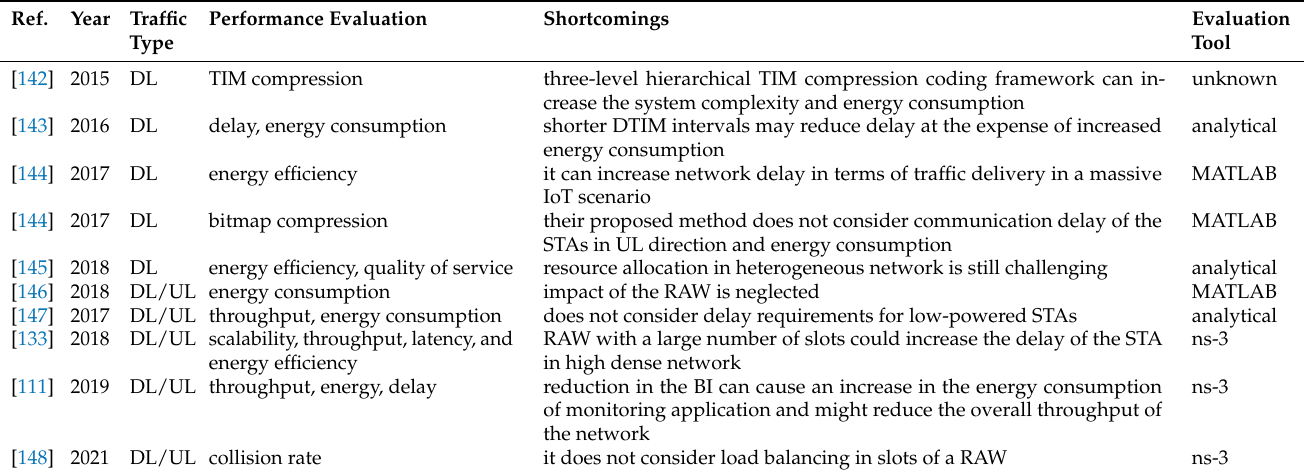
Table 8. Current solutions related to TIM Segmentation of the IEEE 802.11ah WLAN with